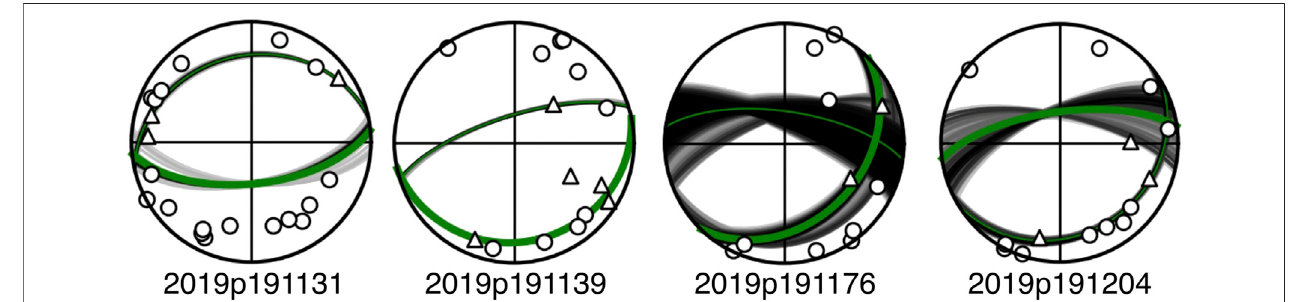
FIGURE 5 | Moment tensors for four earthquakes associated with the dyke intrusion, earthquake ID numbers are below each. Locations are indicated by white stars in Figure 3 . Events 2019p191131, 2019p191139, and 2019p191176 occur within the deep dyke-associated cluster, while event 2019p191204 occurs in the shallowclusteratadepthof1.3 km.MomenttensorsarecalculatedusingMT fi t(PughandWhite,2018)andshowthefullrangeofpossiblenodalplanes,withthehighest probability solution shown in green. Further details of the moment tensor solutions is shown in Supplementary Figures S4 – S7 . Circles and triangles represent positive and negative polarity picks